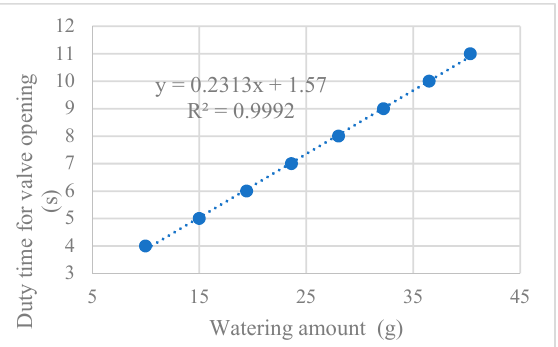
Figure 27. Relationship of duty time for valve opening (4 to 11 s) and watering amount.